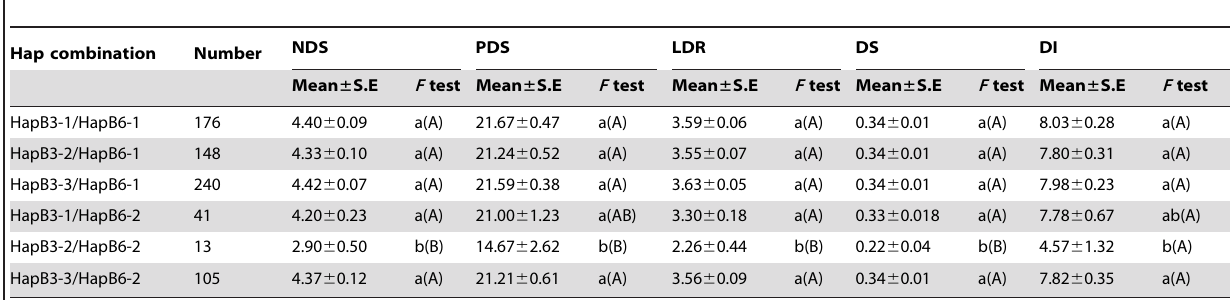
Table 8. Genetic effect analyses of Hap combinations between the HapB3 and HapB6.